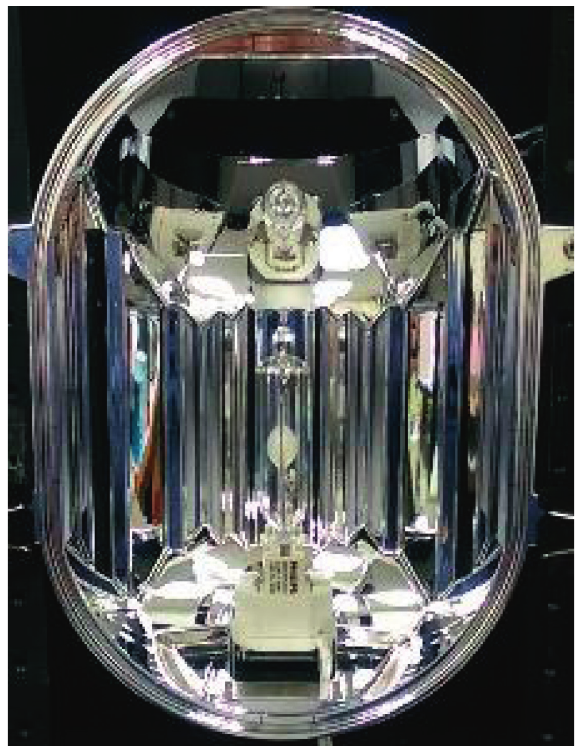
Figure 11: Prototype of proposed street light with freeform-surfaced luminaire.